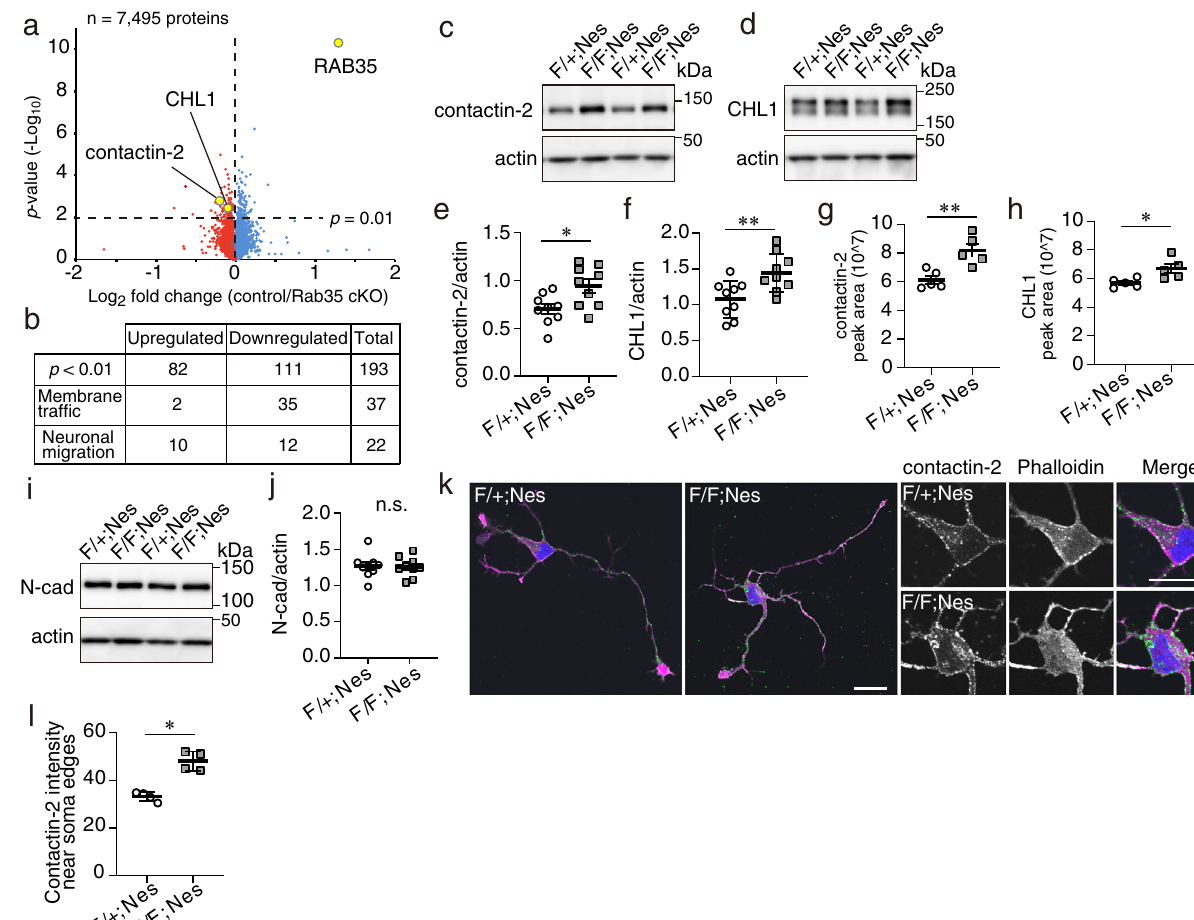
Fig. 5 Quantitative proteomics in Rab35 cKO P0 hippocampus. a Volcano plot of the TMT-based quantitative proteomes identifying the dysregulated proteins in Rab35 cKO hippocampus in comparison with the control hippocampus ( n = 5 mice per genotype). b Number of proteins identi fi ed as signi fi cantly dysregulated and as either membrane traf fi c-related or neuronal migration-related. c , d Western blot analysis of control and Rab35 cKO P0 hippocampi using anti-contactin-2, anti-CHL1, and anti-actin antibodies. e , f Quanti fi cation of contactin-2 ( c ) and CHL1 ( d ) protein levels in control and Rab35 cKO P0 hippocampi. Band intensities of the indicated proteins were normalized to those of actin ( n = 9 mice per genotype). Unpaired Student ’ s t - test; e , p = 0.0153; f , p = 0.0095. g , h Levels of contactin-2 ( g ) and CHL1 ( h ) were quanti fi ed by targeted MS using the PRM method ( n = 5 mice per genotype). Unpaired Student ’ s t -test; g p = 0.0053; h p = 0.0229. i Western blot analysis of control and Rab35 cKO P0 hippocampus using anti-N-cadherin and anti-actin antibodies. j Quanti fi cation of N-cadherin protein levels in the control and Rab35 cKO P0 hippocampus ( n = 9 mice per genotypes). Unpaired Student ’ s t -test, p = 0.9020. k Representative images of DIV 2 hippocampal primary neurons stained for contactin-2 (green), rhodamine-phalloidin (magenta) and DAPI (blue). Scale bar, 20 μ m. l Quanti fi cation of contactin-2 intensity at the somatic plasma membrane in control ( n = 4) and Rab35- de fi cient ( n = 4) cells. Thirty neurons from four different cultures per genotype were analyzed. Mann – Whitney U -test, p = 0.0286. Data represent the mean ± SEM; n.s. not signi fi cant ( p > 0.05); * p < 0.05; ** p <